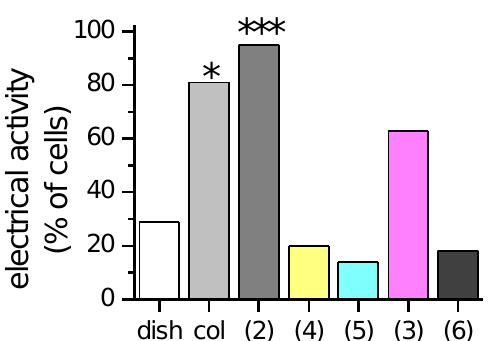
Figure 3. Percentage of F-11 cells endowed with electrical activity on di ff erent neoglycosylated collagen matrices: col, pristine collagen; ( 2 ) α -glucosides, ( 4 ) sialyl α -(2 → 6)-galactoside, ( 5 ) sialyl α -(2 → 3)-galactoside, ( 3 ) β -galactoside, ( 6 ) chondroitin sulphate. Statistical analysis was performed using the Chi-squared test. Significance was set for p < 0.05. * p < 0.05, *** p <